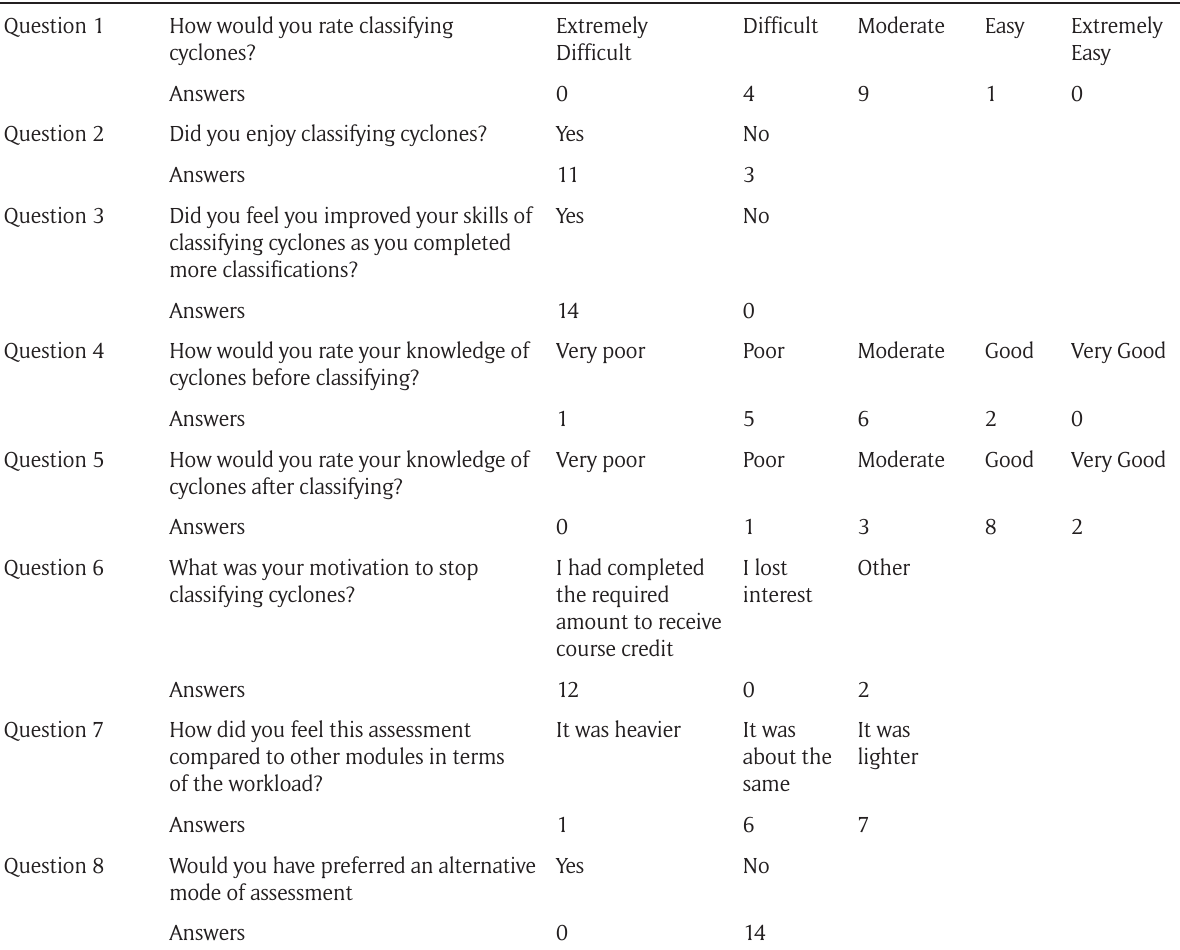
Table 7: Questionnaire results from MU students. For each question, the response options available to students are provided together with the distribution of